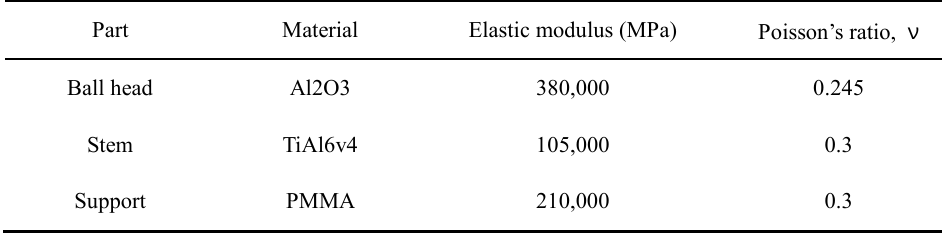
Table 1. Material properties used in femoral head FE